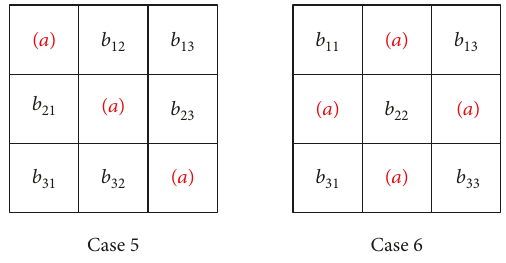
Figure 3: The payo ff matrices of Case 5 and Case 6.